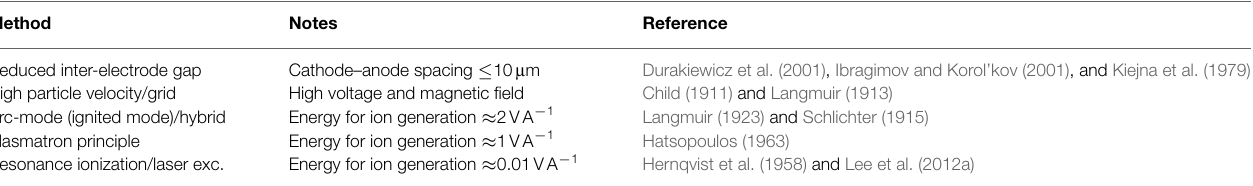
TABLE 1 | Approaches for reducing space charge effects in thermionic converters.